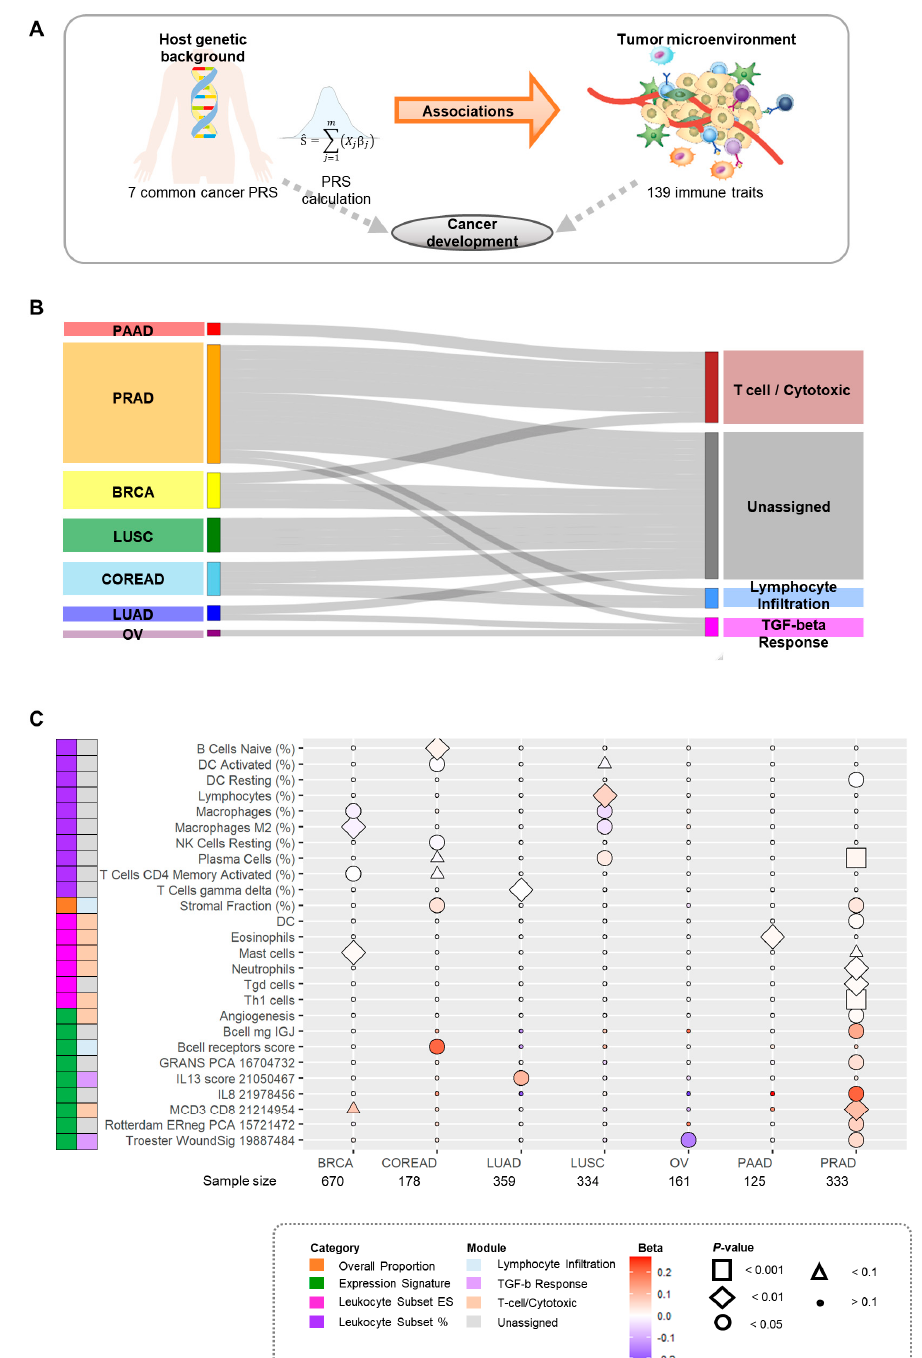
Figure 1. Overall associations between polygenic risk scores (PRSs) for cancers and immune traits. ( A ) Overall workflow for assessing the effect of PRSs for cancers on immune traits. ( B ) Overall proportion of cancer types in each immune module (nominal p < 0.05). The thickness of line indicates − log 10 P . ( C ) Overall associations between PRSs for cancers and immune traits (nominal p < 0.05.) Immune traits were presented when a nominal p < 0.05 against at least one type of cancer was observed. The bottom figure represents the stratified analyses by intrinsic molecular subtypes of breast cancer between the PRSs for breast cancer and immune traits. Abbreviations: BRCA, breast cancer; COREAD, colorectal cancer; LUAD, lung adenocarcinoma; LUSC, lung squamous cell carcinoma; OV, ovarian cancer; PAAD, pancreatic cancer; PRAD, prostate